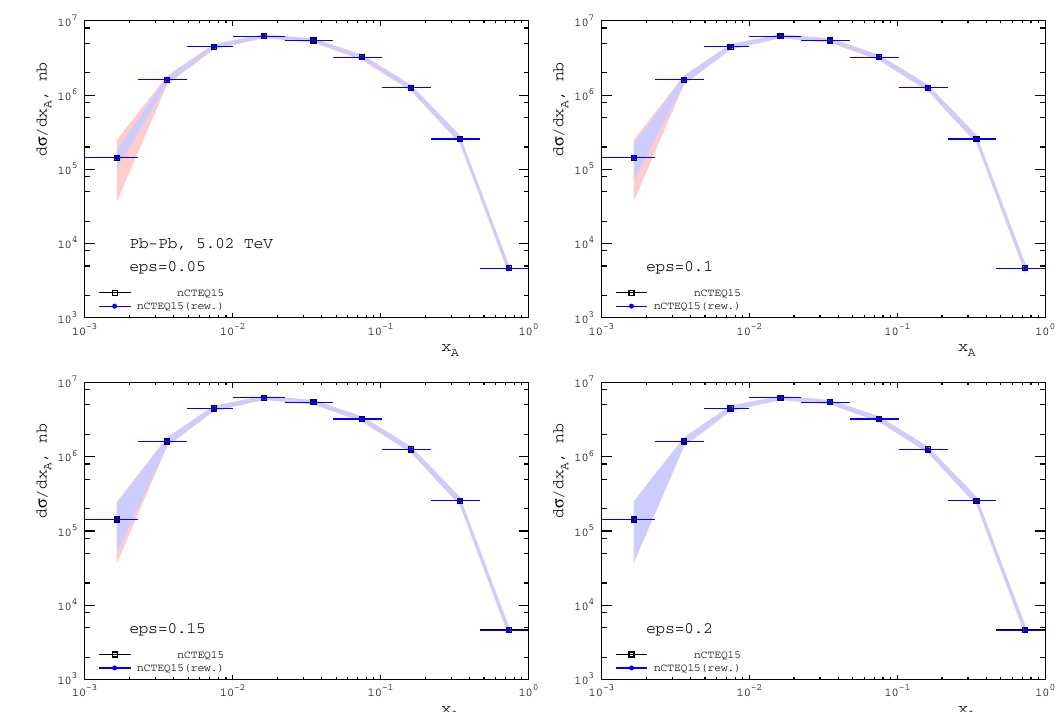
Fig. 1 Thedijetphotoproductioncrosssectionasafunctionof x A with (blue solid circles and error bands) and without (black open squares and red error bands) the Bayesian reweighting. The calculations correspond